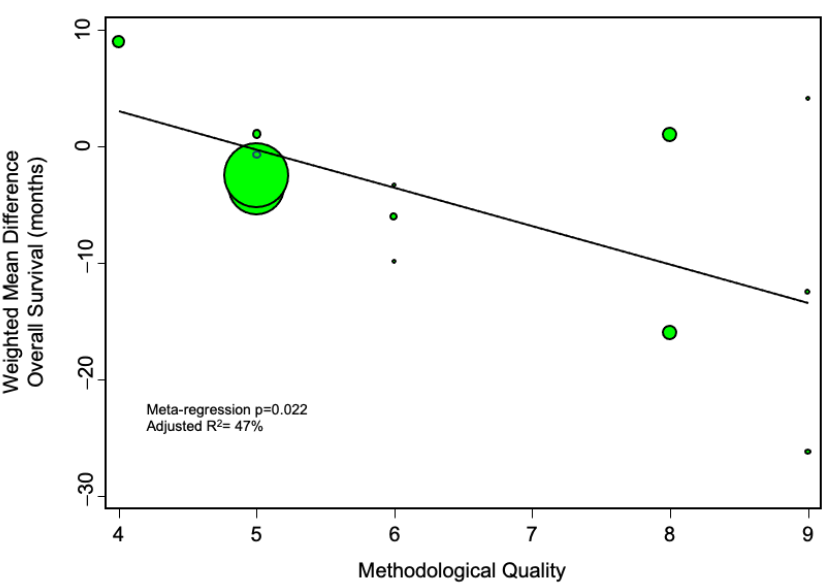
Figure 6. Meta-regression analysis, evaluating the impact of methodological quality (as assessed by the Newcastle-Ottawa scale) on the calculated pooled estimate. The more negative the weighted mean difference, the more harmful the effect of pedicle clamping on overall survival. The diameter of the individual studies indicates their relative weight in the meta-analysis.